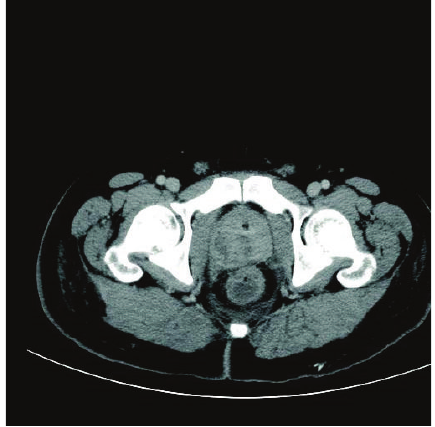
Figure 1: Prostate.